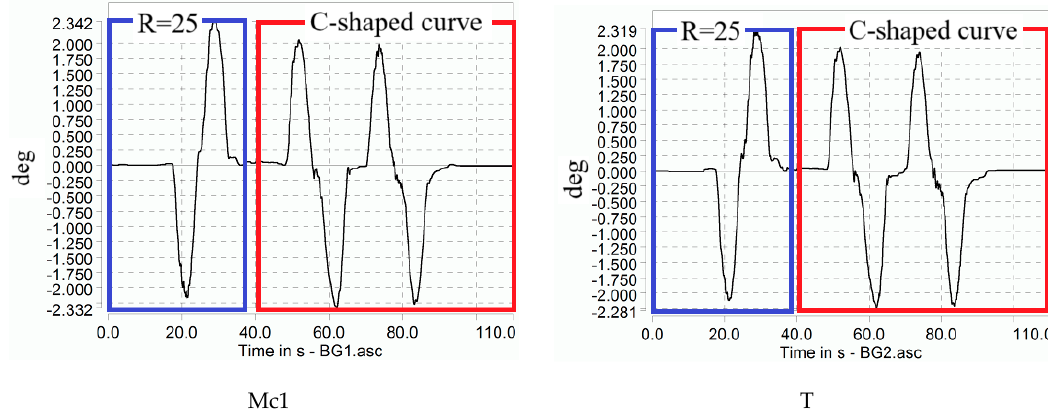
Figure 25. Mc1 and T relative to their own bogies on the C-shaped curve line.